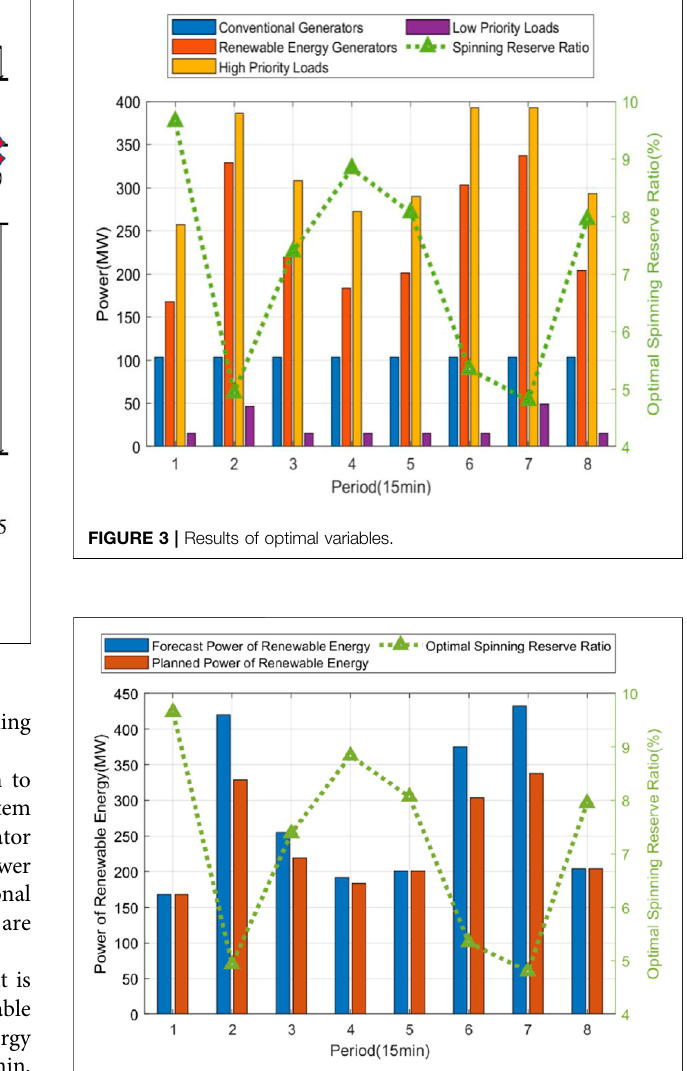
FIGURE 4 | The relationship between the optimal ratio of renewable energy reserve of each period and the forecast power and planned power of the renewable